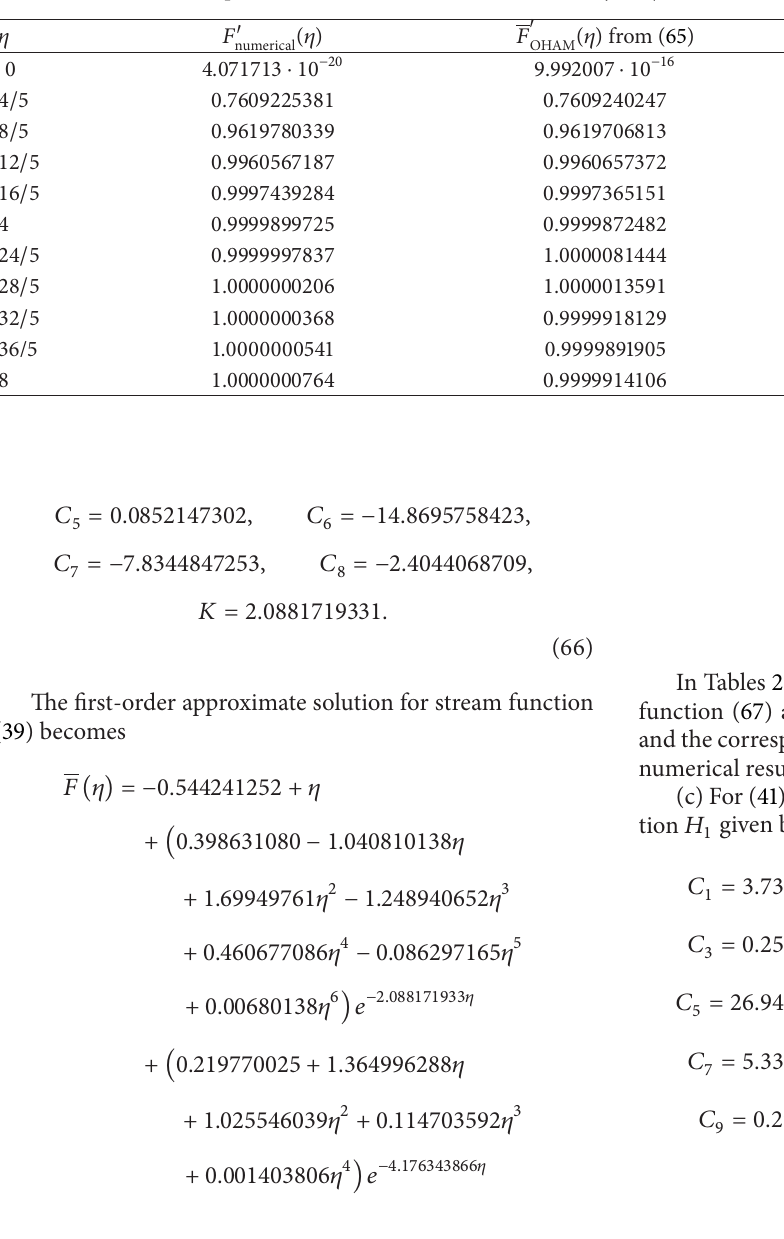
Table 20: Comparison between OHAM results for velocity 𝐹